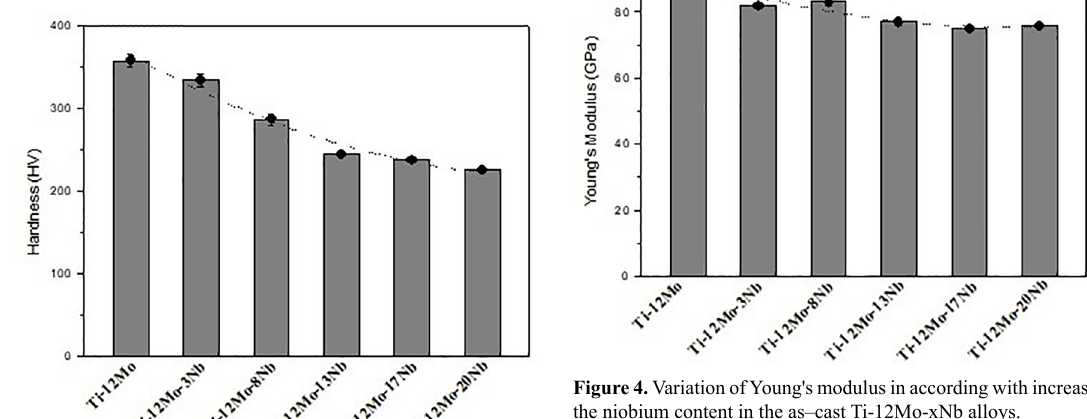
Figure 2. OM of the as-cast Ti-12Mo-xNb alloys: (a) x = 0; (b) x = 3%; (c) x = 8%; (d) x = 13%; (e) x = 17% e (f) x = 20% Figure 3 shows the hardness values in function of the increase of niobium addition in the as–cast Ti-12Mo-xNb alloys. The hardness of as–cast Ti-12Mo-xNb was influenced by addition niobium. According with the technique used in the work, the alloys showed single β phase in the microstructure. Experimental observations showed that increasing niobium concentration in the Ti-Mo system with β matrix, decreases hardness as also reported by Zhang et al. 24 . In this case, niobium reduces the lattice parameter and affects the relationship ac .